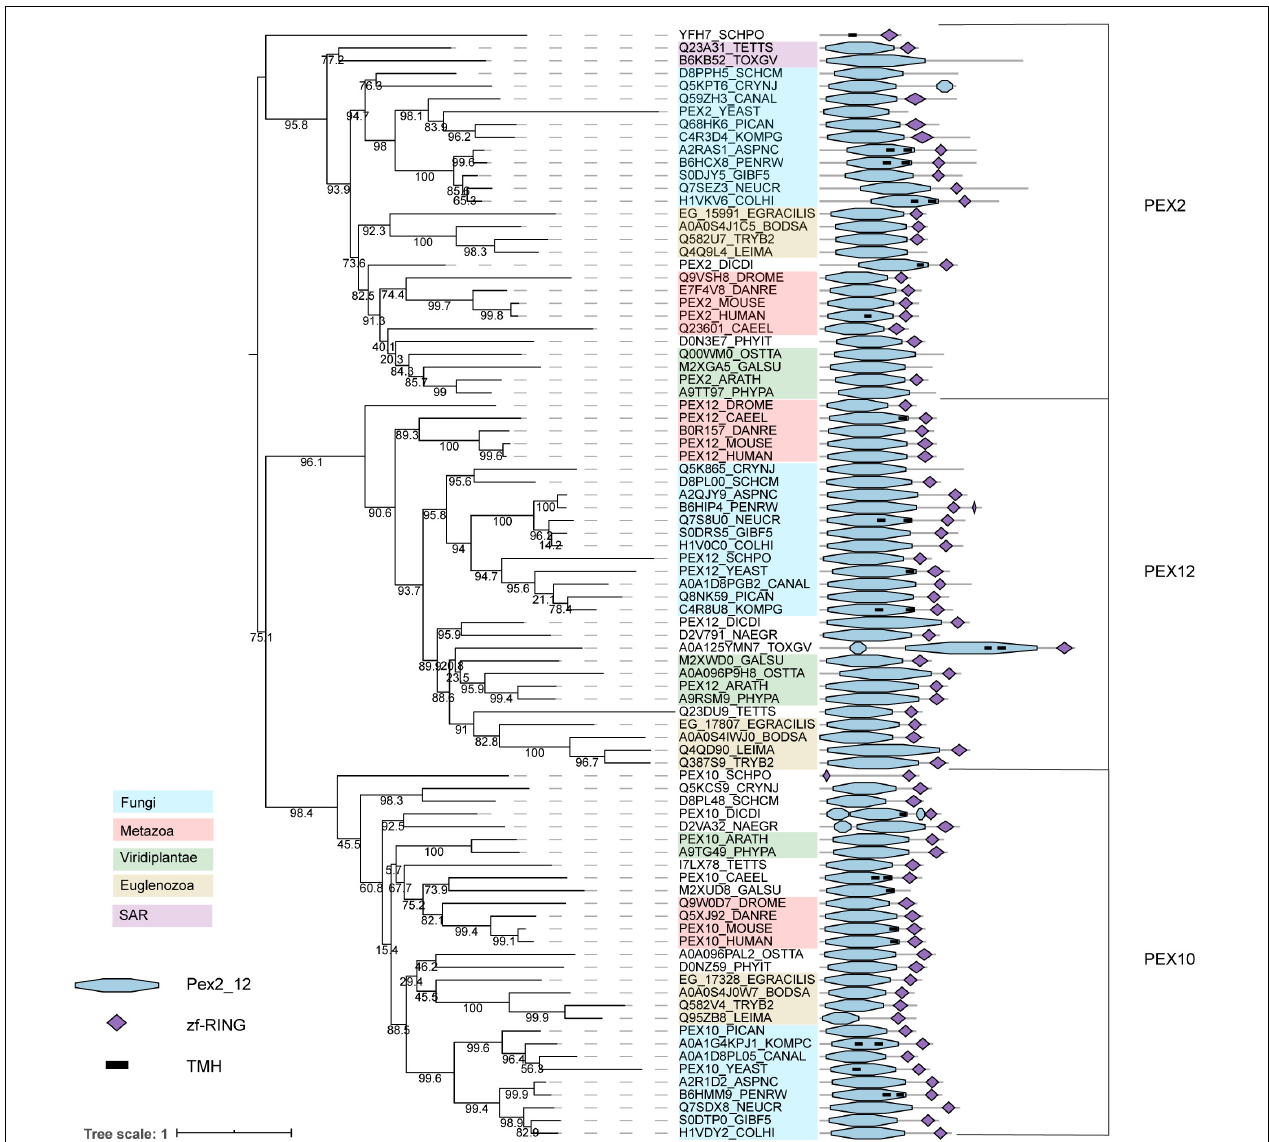
FIGURE 5 | Phylogeny and protein features of PEX2/10/12 orthologs. The phylogeny is rooted at mid-point to ease the visualization and labels of the main taxonomic groups are colored accordingly to the legend. Note that the topology does not necessarily reflect the actual evolutionary trajectory of such proteins. Protein domain architecture is defined by pfam annotations and transmembrane helix according to TMHMM